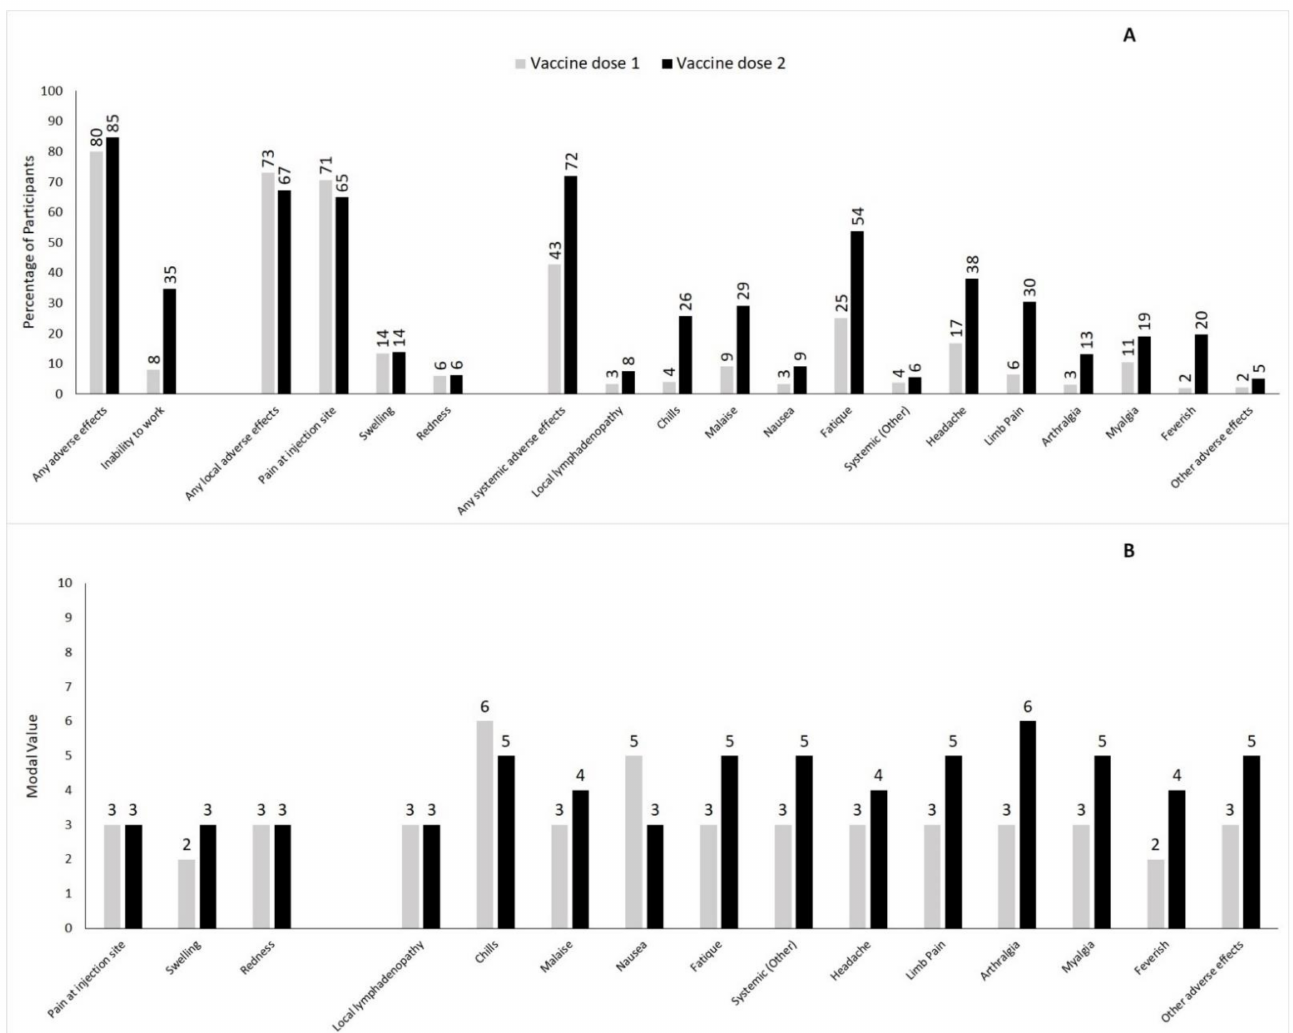
Figure 2. Panel ( A ) Frequency of selected local or systemic adverse effects after first and second dose of BNT162b2 mRNA vaccine given as percentage of participants. Panel ( B ) Degree of severity of selected local or systemic adverse effects after first and second dose of BNT162b2 mRNA vaccine given as modal